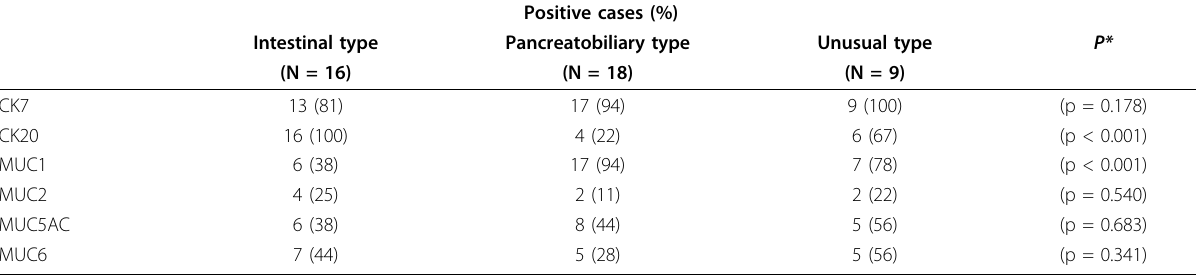
Table 2 Immunohistochemical Expression by Histological Classification